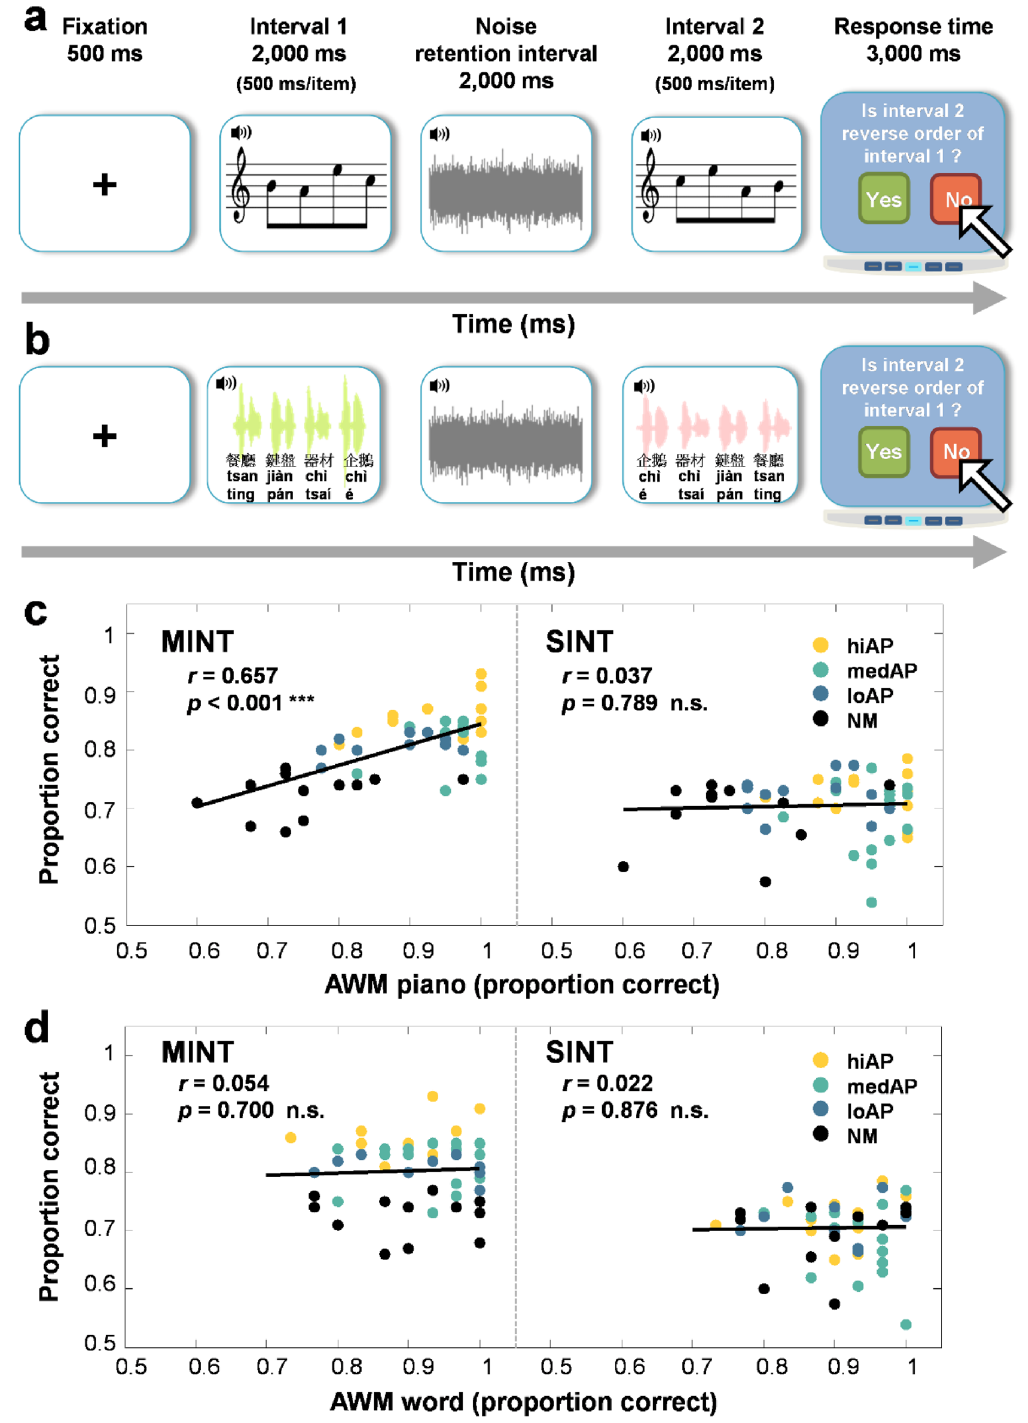
Figure 5. Correlations of the auditory working memory task and performance on MINT and SINT. Schematic diagram of the AWM task procedure for ( a ) piano tones and ( b ) Mandarin disyllabic compound words. Scatterplots depict correlation between ( c ) AWM task on piano tones with performance on MINT and SINT. ( d ) AWM task on words with performance on MINT and SINT. Different colored dots represent musicians with different quasi-AP proficiency